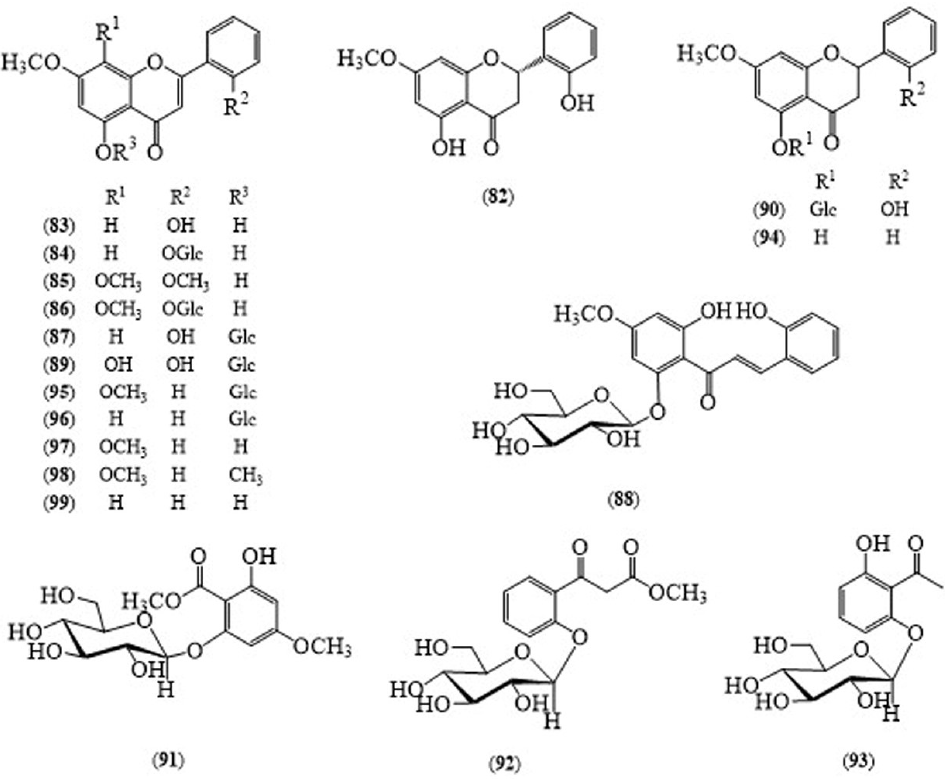
Figure 8. Structures of selected compounds isolated from Andrographis echioides.